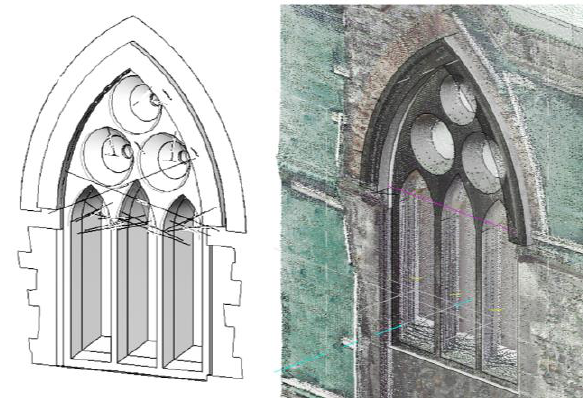
Figure 6. A Parametric model on the left and its insertion based on the TLS data into the Revit wall.